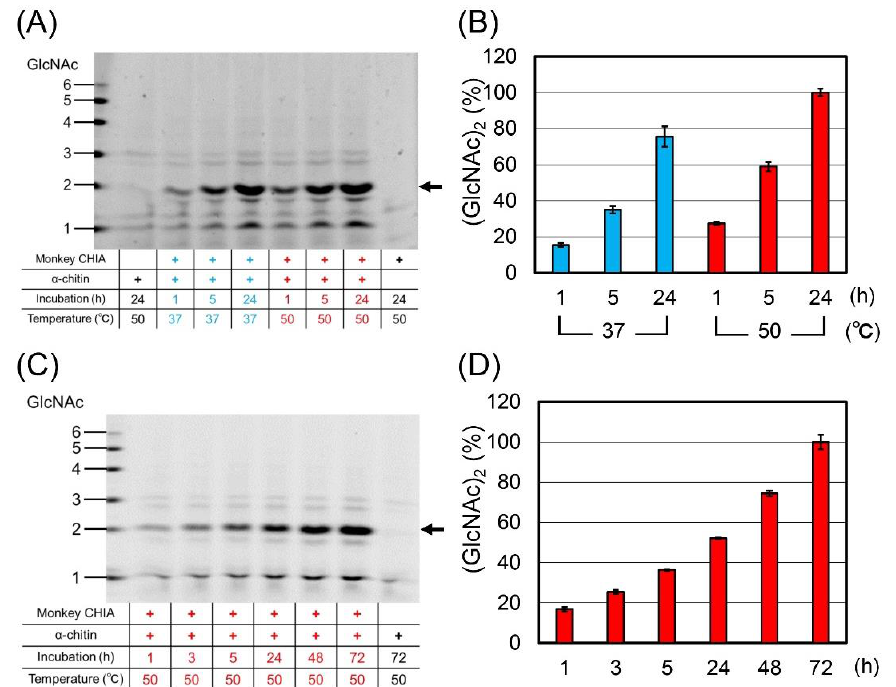
Figure 1. Degradation of chitin by monkey CHIA at high temperatures. ( A ) Degradation of α -chitin at 37 °C or 50 °C and pH 5.0. Size standards on the left margin are defined as chitin oligomers. ( B ) Quantitative data of (GlcNAc) 2 at each temperature. Fluorescence intensity is estimated from the results in ( A ). The quantitative data express the percentage of the maximum signal of (GlcNAc) 2 achieved at 24 h and 50 °C that was set to 100%. ( C ) The time-dependent change in degradation products from α -chitin at 50 °C. Size standards on the left margin are defined as chitin oligomer standards. ( D ) Quantitative data of (GlcNAc) 2 for each incubation time. Fluorescence intensity is estimated from the results in ( C ). The quantitative data express the percentage of the maximum signal of (GlcNAc) 2 achieved at 72 h, set to 100%. The images in ( A , C ) were cropped from red dotted lines on original full-length gel images, shown in Supplementary Figures S2 and S4. Error bars repre- sent mean ± standard deviation from a single experiment conducted in triplicate (Supplementary Figures S3 and